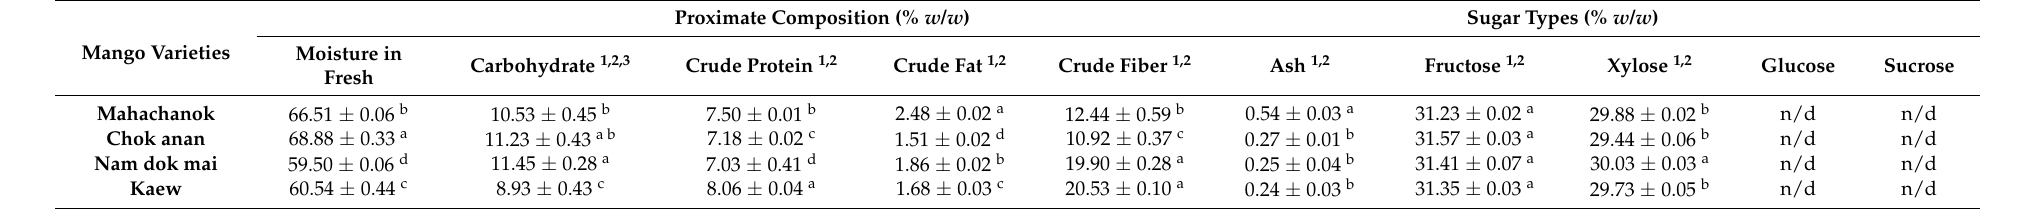
Table 3. Proximate and sugar analyses of different varieties of mango